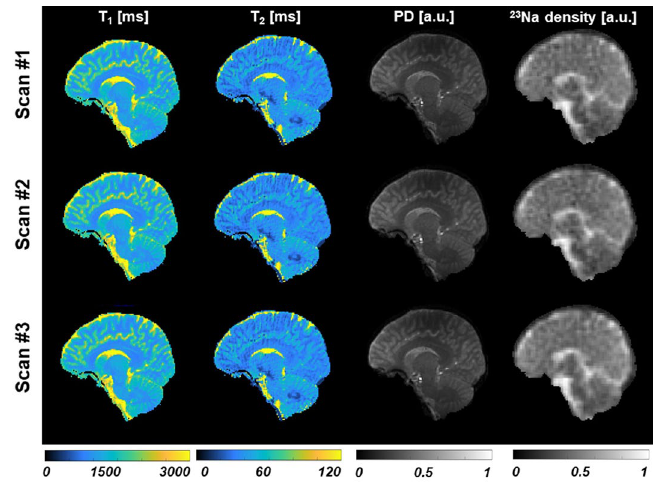
Figure 1. Maps from the 3 scans acquired on subject 1 (after co-registration and masking) with simultaneous 1 H MRF/ 23 Na MRI. The in-plane resolution is 1.5 × 1.5 mm 2 for the proton images and 2.85 × 2.85 mm 2 for the sodium image. Slice thickness is 3 mm for both nuclei. PD is proton